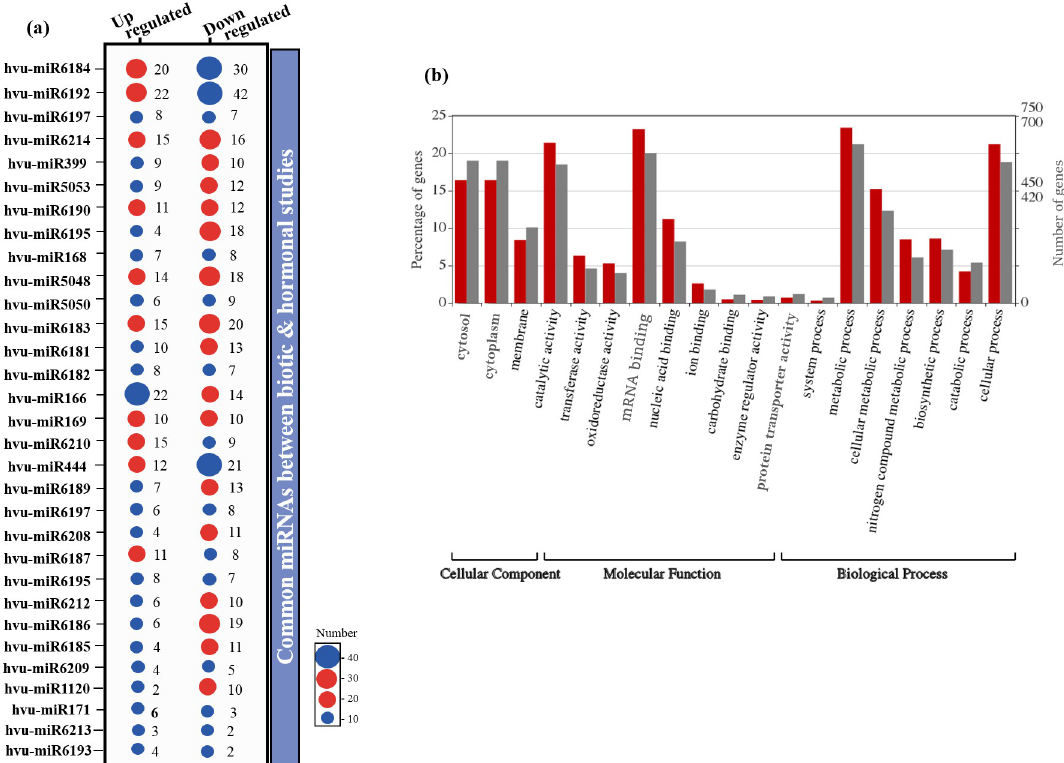
Fig 8. Identification of miRNAs and their targets. (a) Common miRNAs between biotic and hormonal studies are showed. The Y- axis refers to the number of miRNAs. The X-axis shows miRNA families. (b) Shows GO classification for the target genes of differentially expressed miRNAs. Categorization of miRNA target genes with WEGO for biotic and hormonal studies are presented. The horizontal axis is the GO classification; the vertical is the percentage of genes (left) and number of genes (right). The miRNAs are divided into GO categories. The genes targeted by the entire miRNAs: red column, the genes targeted by the differentially expressed miRNAs: gray column.